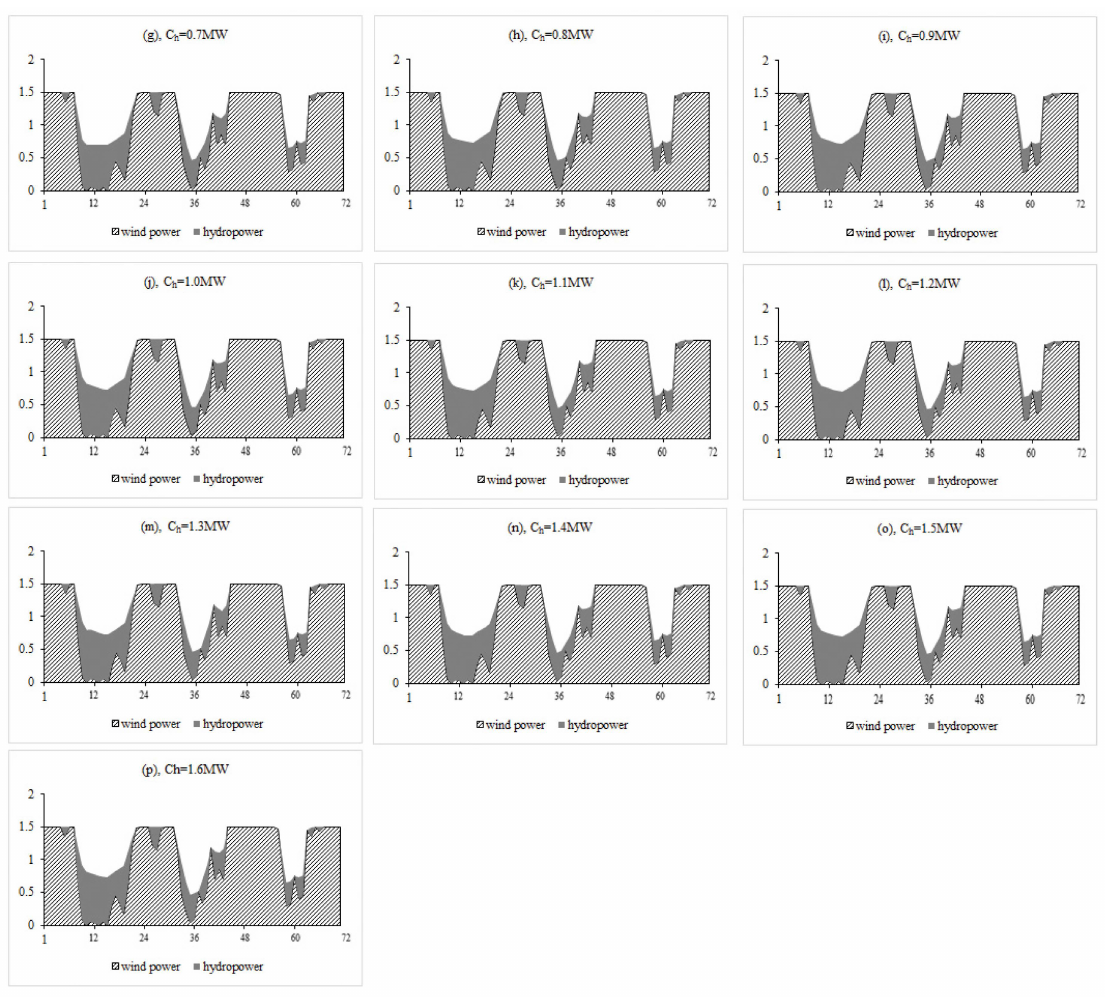
Figure 13. Combined output with different hydropower capacities in dry season. ( a ) the combined output with hydropower capacities of 0.1 MW; ( b ) the combined output with hydropower capacities of 0.2 MW; . . . ; ( p ) the combined output with hydropower capacities of 1.6 MW.